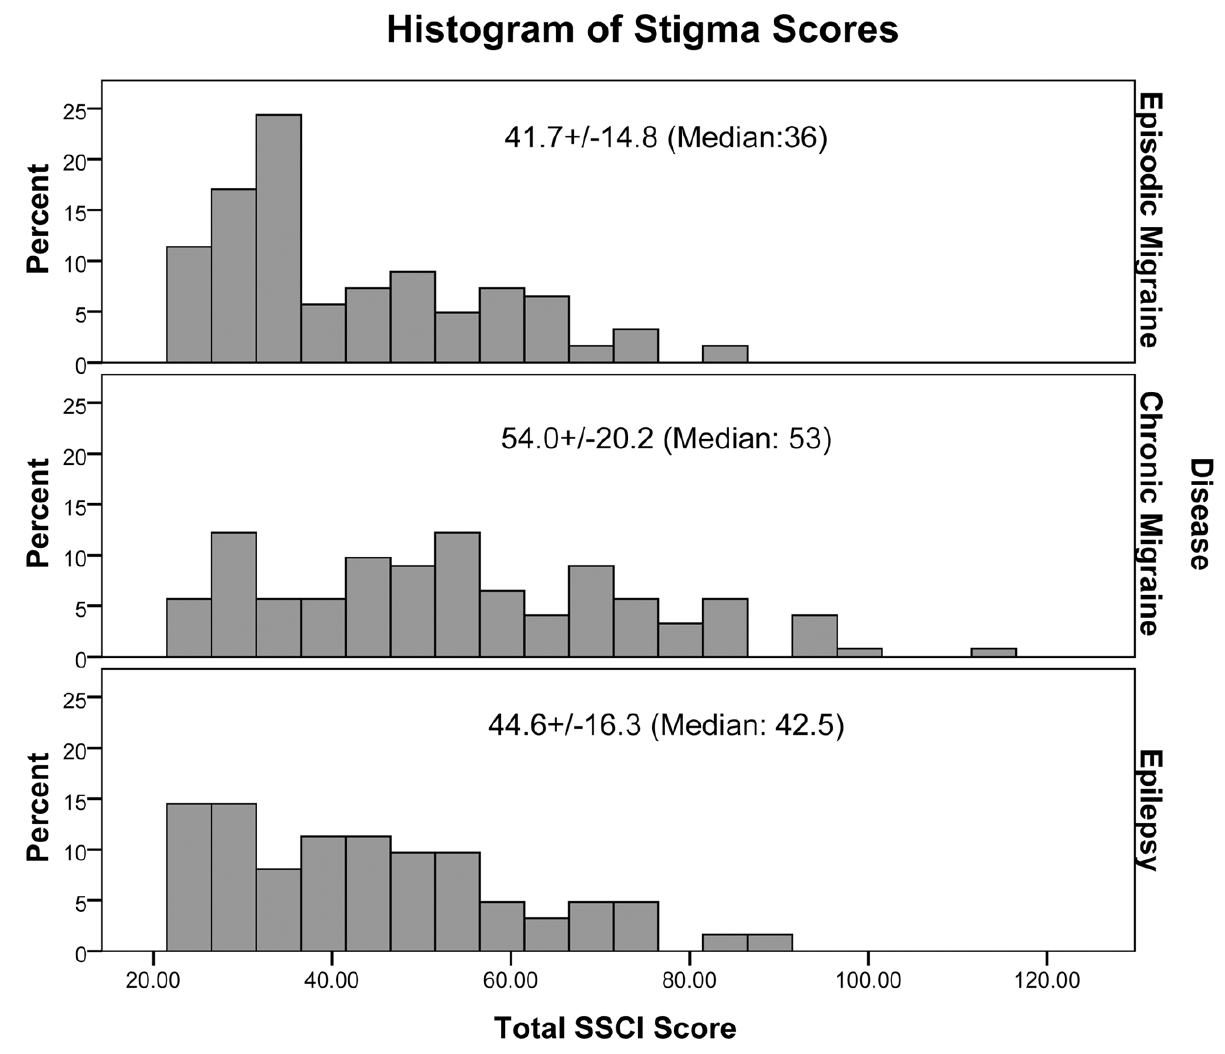
Figure 3. Stigma Scores. Distribution of stigma scores for EM, CM, and Ep. Scores for CM are significantly higher than for EM or Ep. CM scores were higher than SSCI scores of 42.7 + / 2 19.7 for an internet panel of diverse neurological patients used to validate the SSCI (p , 0.001, z-test), while EM and Ep were not.